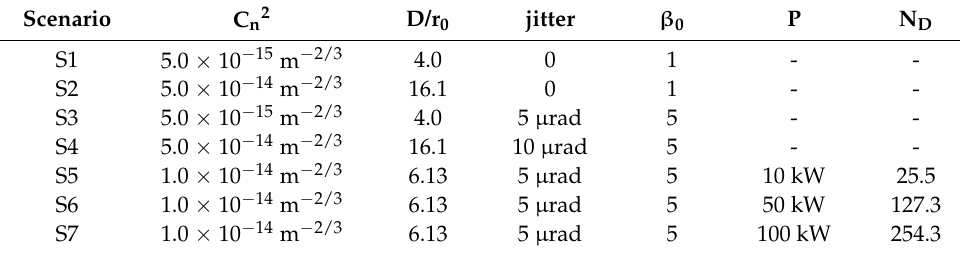
Table 2. Scenarios used in the wave optics